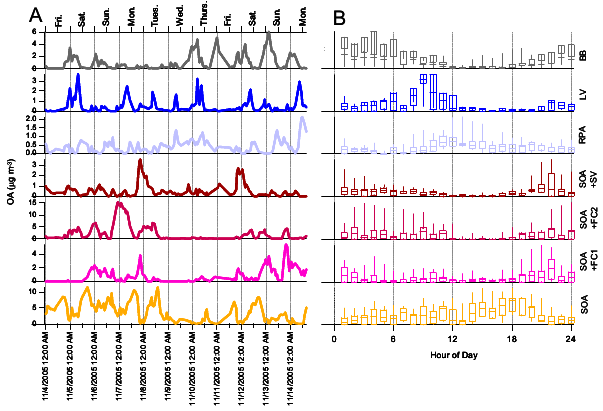
Fig. 11. (A) Individual PMF factor timelines over the fall focus period (4 November–14 November). (B) Diurnal averages for fall factors. Time is in PST (=local time during fall).